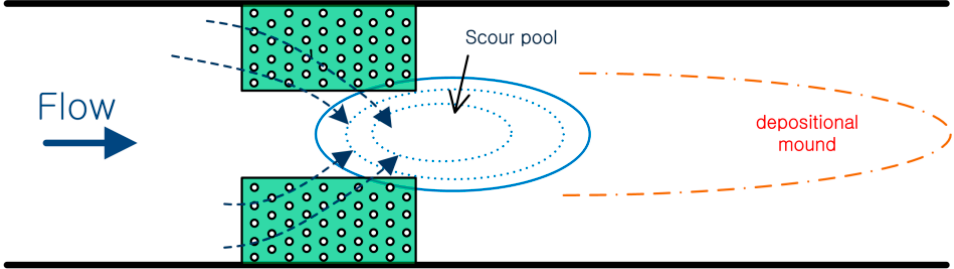
Figure 1. Schematic view of the flow and bed morphology around the paired obstructions.